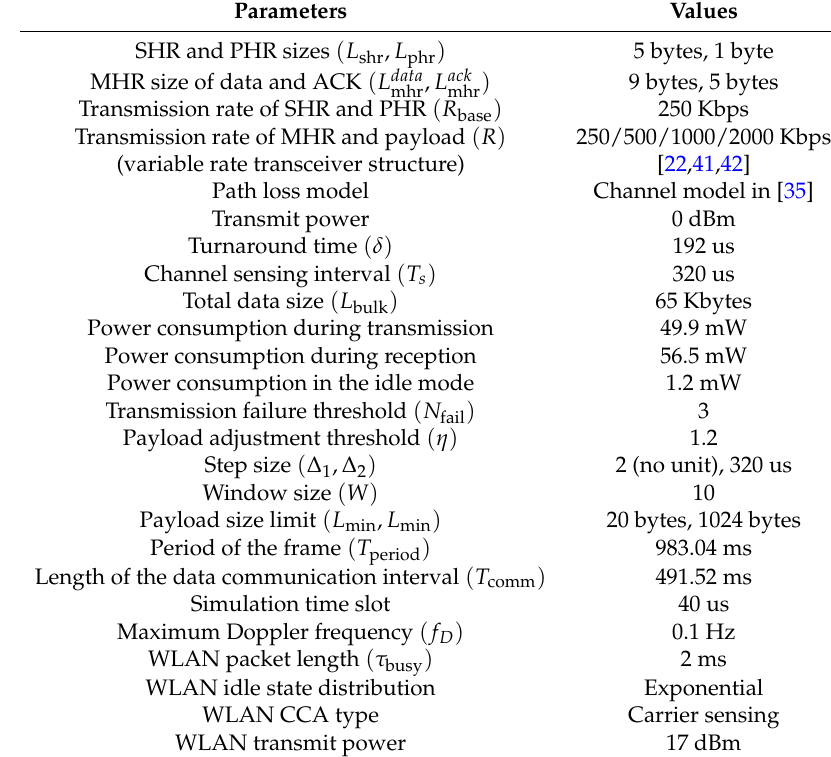
Figure 3. WSN simulator structure. Table 1. Simulation parameters. SHR, synchronization header; PHR, physical layer packet header; MHR, MAC layer packet header; CCA, clear channel